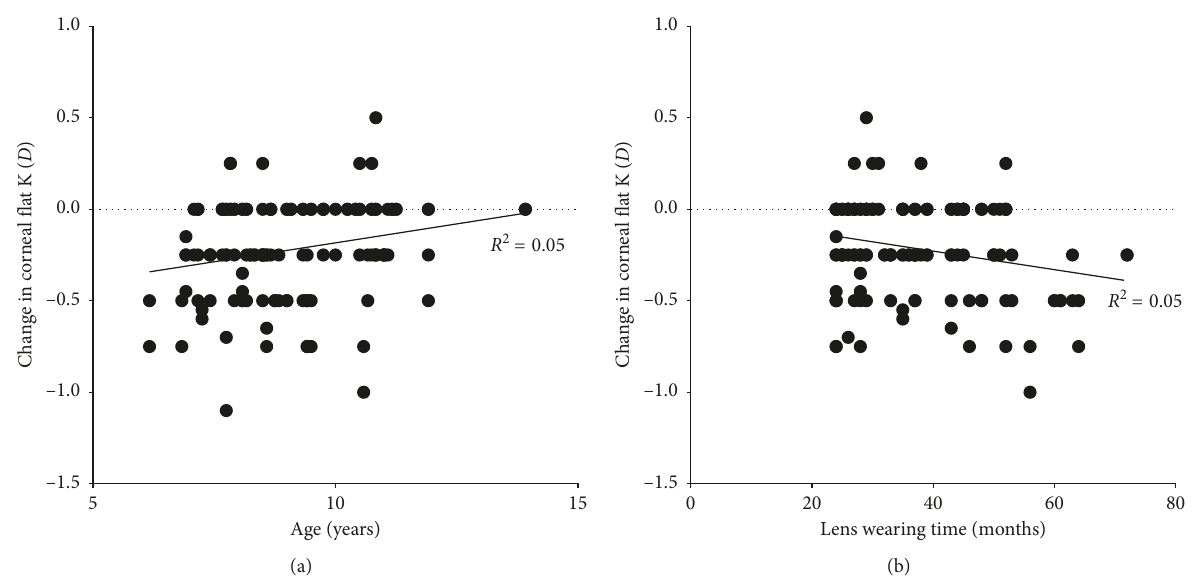
Figure 2: Scatterplots showing the change in corneal flat K after cessation of ortho-k lens wear, in the function of subject’s starting age for ortho-k (a) and lens wearing time (b).